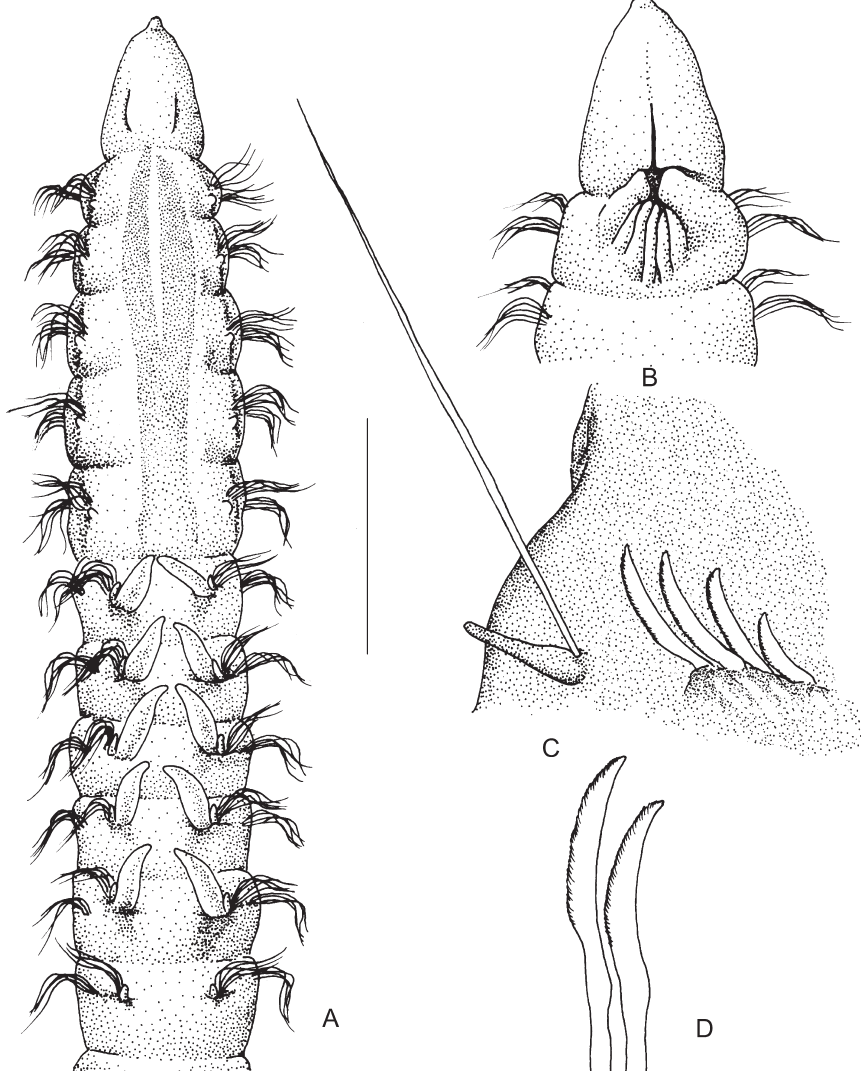
Fig . 4. – Levinsenia kantauriensis n. sp.: A, anterior region, dorsal view; b, anterior region, ventral view; c, parapodium, chaetiger 29; D, modified neurochaetae. Scale bar: A 350 µ m; b 260 µ m; c 50 µ m; D 40 µ